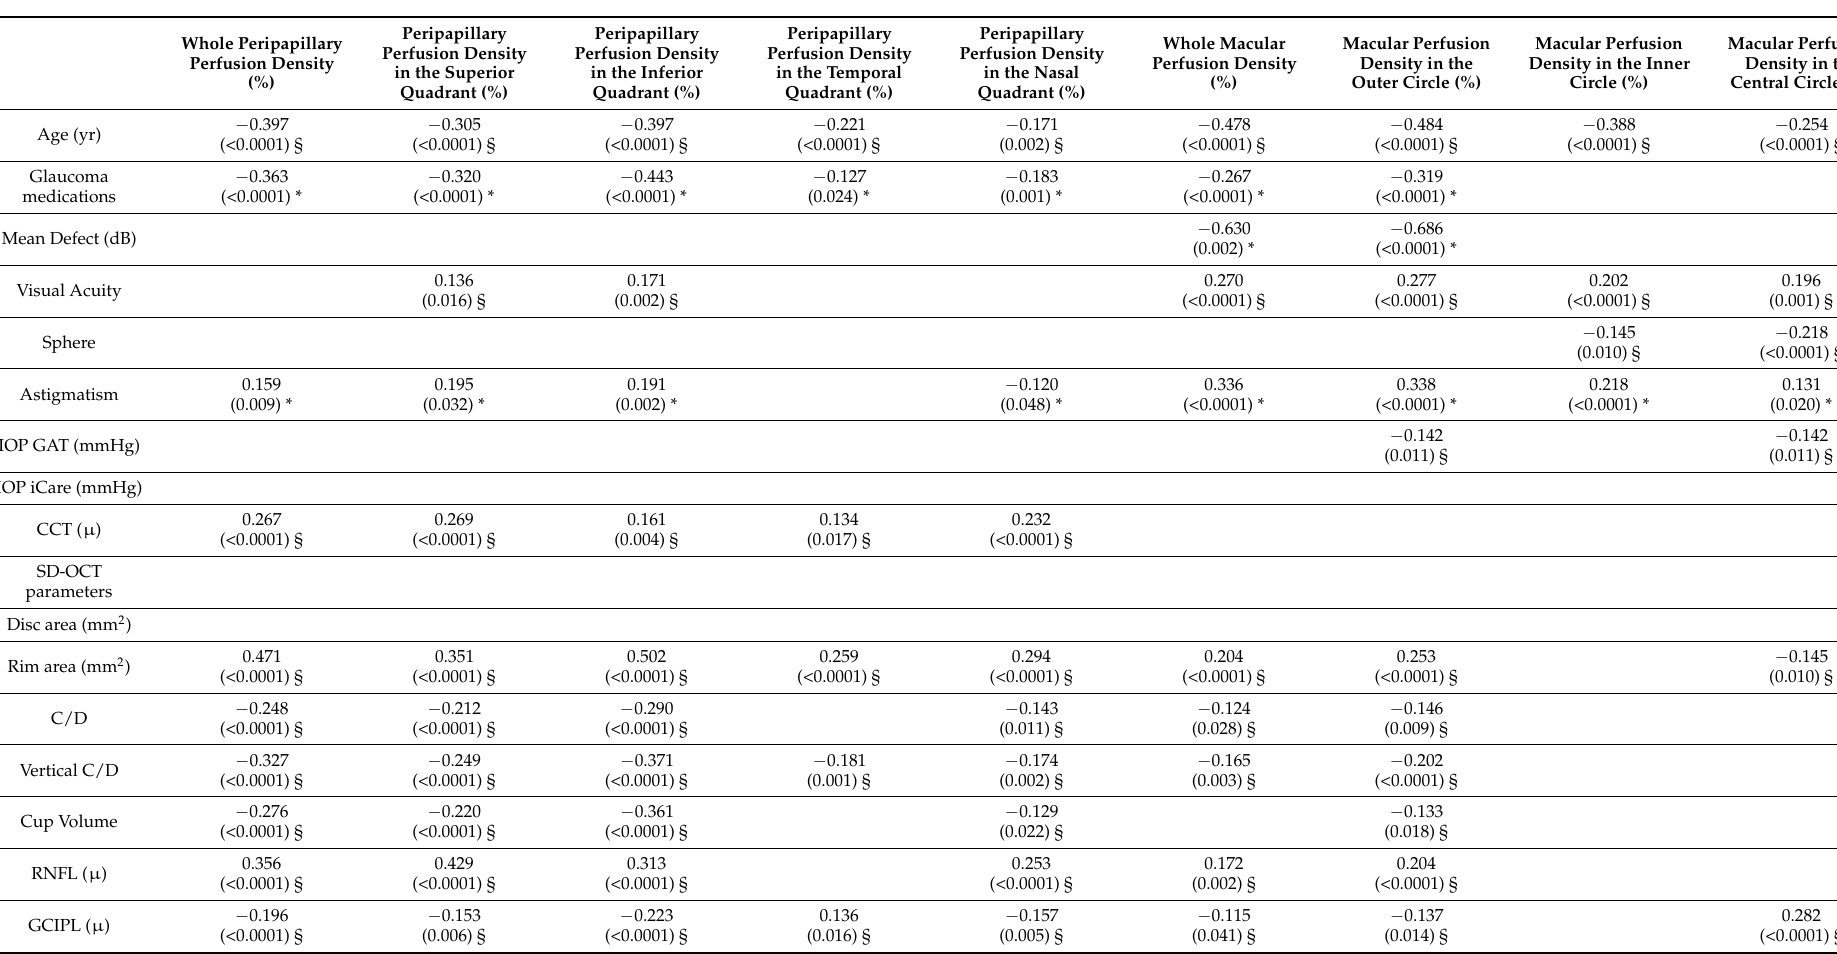
Table 3. Correlation between peripapillary and macular vessel density indices analyzed with OCTA and demographic and clinical data and SD-OCT